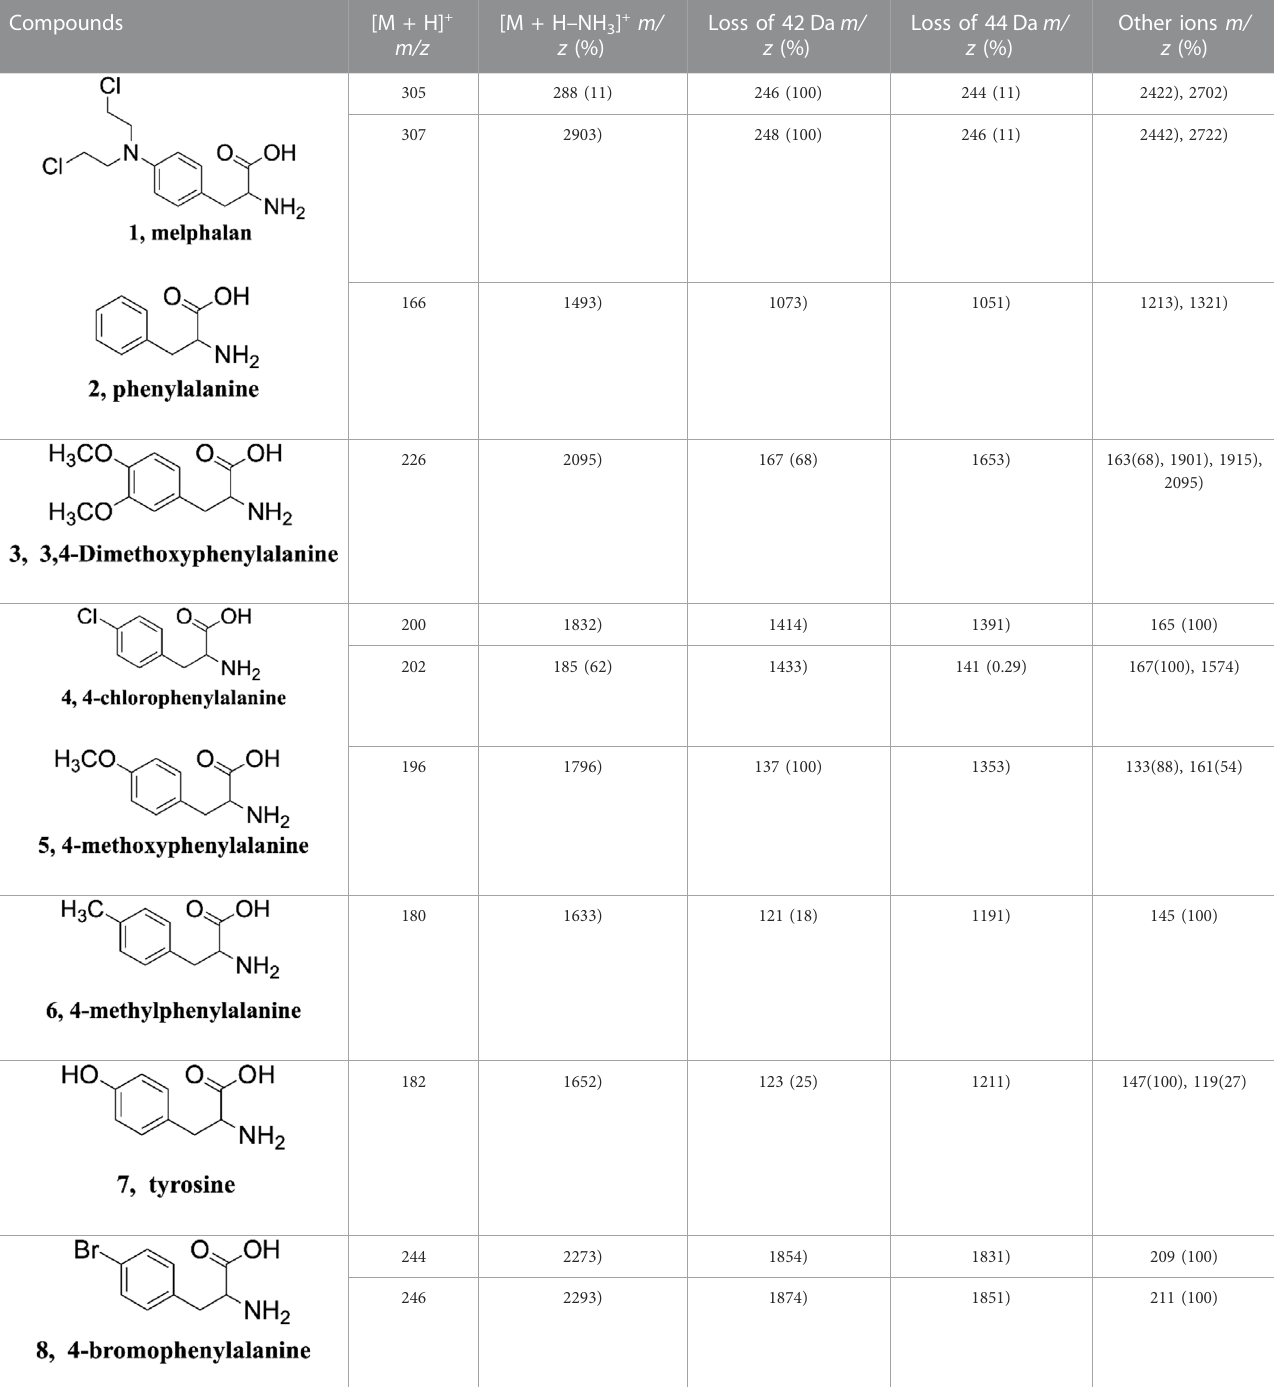
TABLE 2 The CID mass spectra data of [M + H – NH 3 ] + from protonated phenylalanine derivatives (1 – 8).